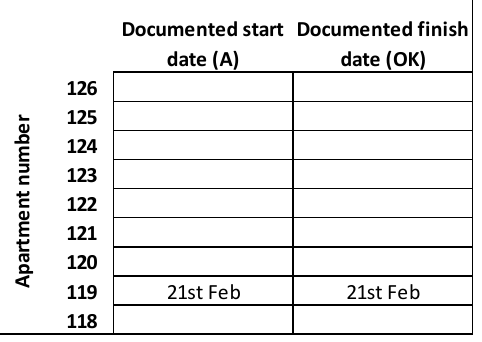
Figure 5. Paper monitoring form used in the first building of the case project.